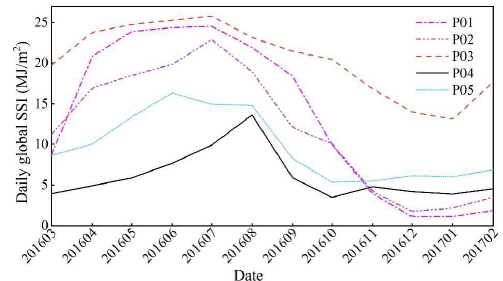
Figure 9 . Monthly variation of daily global SSI in different regions of China from March 2016 to February 2017.